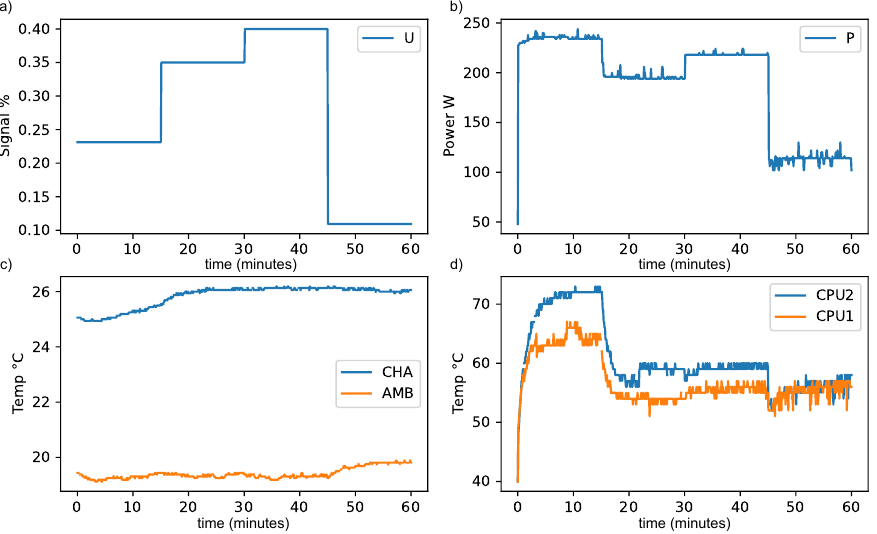
Figure 4. Example of one-hour experimental time series in panels; ( a ) top-left panel shows fan control signal (U), ( b ) top-right panel shows computational load (P), ( c ) bottom-left panel shows chamber (CHA) and ambient (AMB) temperatures, and ( d ) bottom-right panel shows CPU